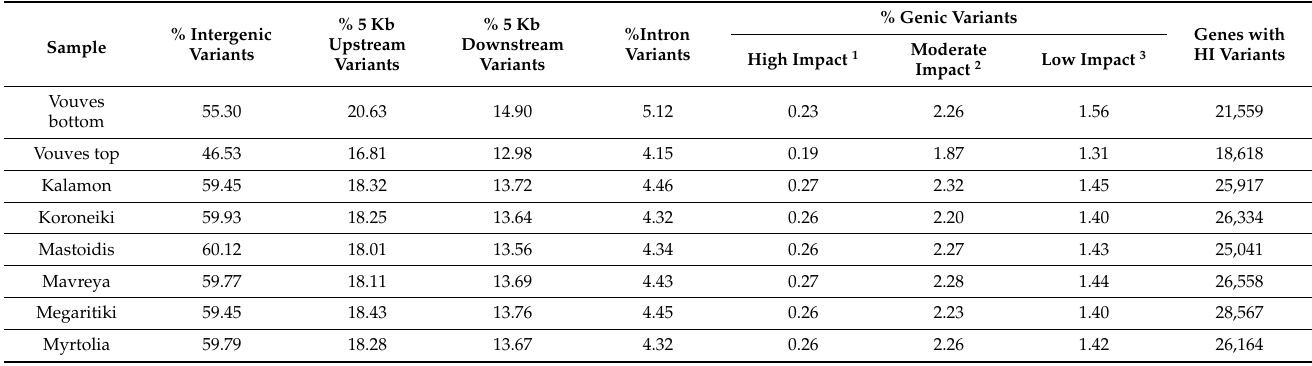
Table 2. Percentage of the different variant categories produced in the variant annotation for each of the